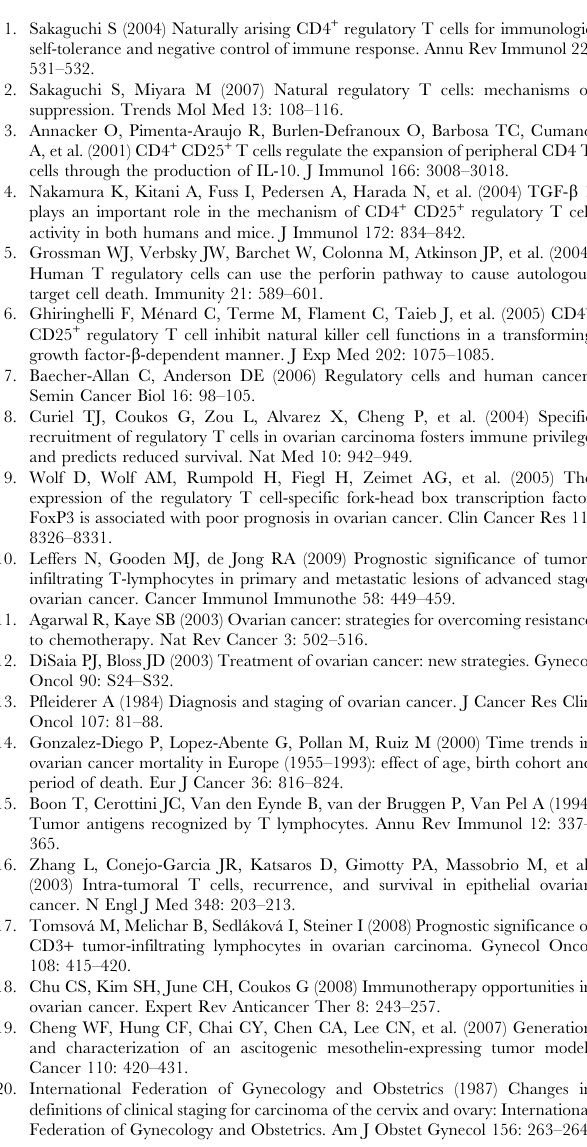
Figure S1 Different expressions of immune components in ascites of early- and advanced-stage ovarian cancer patients. (A) Expression of CD11b + CD33 + Lin 2 myeloid suppressor cells in TACs of early- and advanced-stage ovarian cancer patients. (A1) Representative figures of flow cytometric analyses of myeloid suppressor cells in TACs. (A2) Percentages of myeloid suppressor cells in TACs. Note : The percentages of myeloid suppressor cells in TACs between early- and advanced-stage ovarian cancer patients were not significantly different. ( B ) Concentrations of various cytokines in ascites of ovarian cancer patients. B1, IL-5; B2, IL-9; B3, IL-12; B4, IL-13; B5, IL-17. Note : The concentrations of these cytokines in ascites